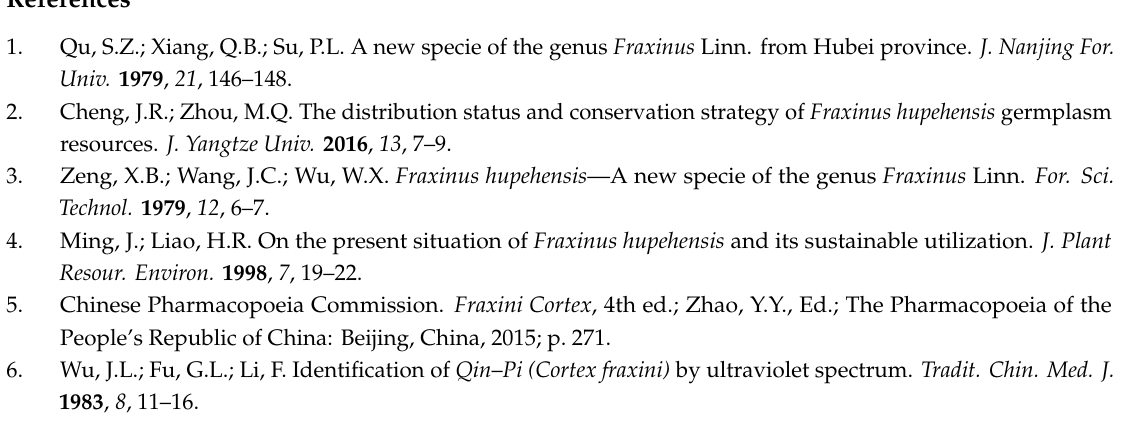
Figure S1: Antifungal activity of 2 against Bipolaris maydis evaluated by the mycelium growth rate method; and Figure S2: Comparison of the e ff ects of 8 – 10 and Cyanazine against Echinochloa crus-galli growth (CK reprents Echinochloa cr us-galli grown on regular